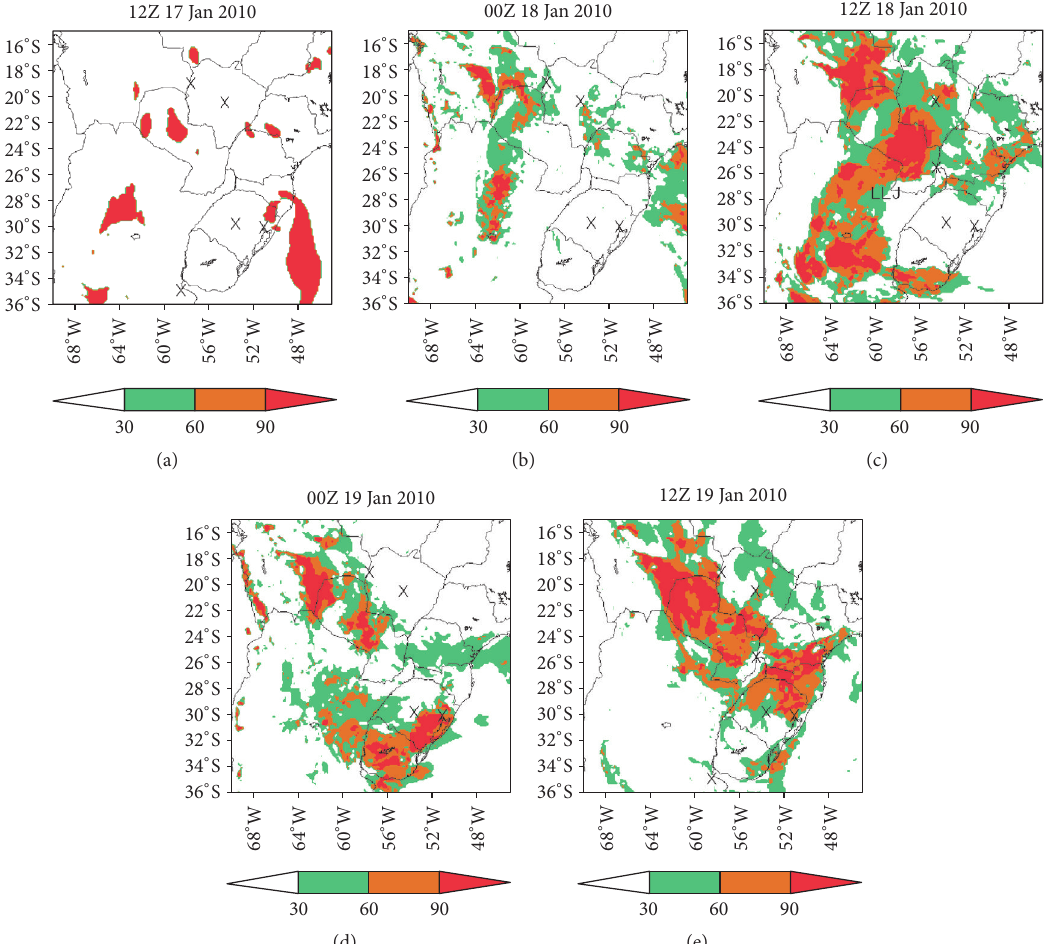
Figure 19: As in Figure 16 but from (a) 12Z 17 January 2010 (model initial condition) to (e) 12Z 19 January 2010.